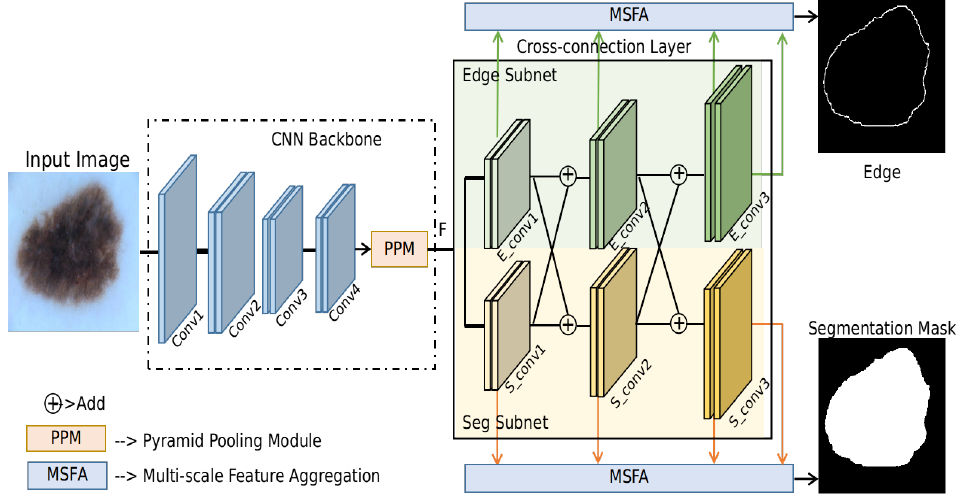
Figure 2. Schematic diagram for the proposed method. Edge prediction is used as an auxiliary task to help the segmentation task. Two parallel branches with the cross-connection layer (CCL) module are implemented so that the two tasks can interact with each other and boost each other’s performance in turn. A multi-scale feature aggregation (MSFA) module is used to aggregate information from feature maps of different